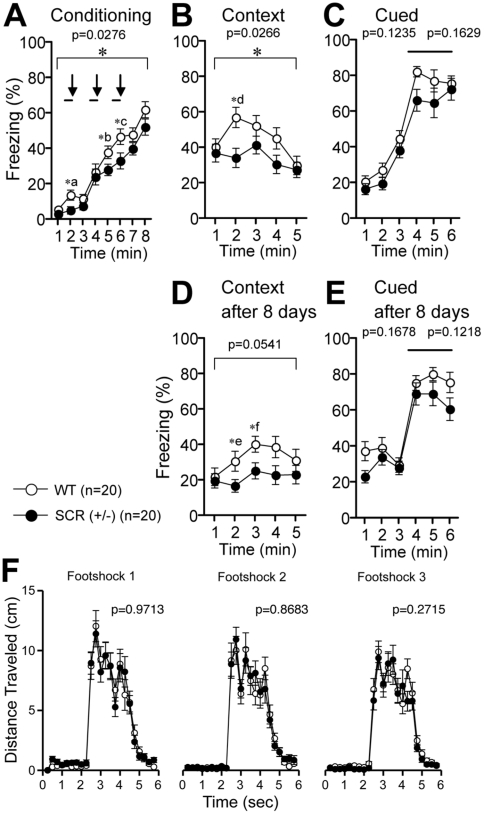
Contextual and cued fear conditioning in SCR (+/−) mice.(A) Percentage of time showing freezing during the training phase. A tone was presented for 30 s (bars) followed by a 2 s foot shock (arrows). (B) Reduced freezing was observed in the SCR (+/−) mice during the contextual test conducted at 24 h after conditioning. (C) Freezing during the tone-cued (bar) test with altered context in SCR (+/−) mice. (D, E) Retention of fear after 8 days. Percentage of time showing freezing during the contextual test in wild-type and SCR (+/−) mice (D) and freezing during the tone-cued (bar) test with altered context (E) at 8 days after conditioning. (F) Distance traveled soon after each foot shock at the training phase. (*) Significantly different in genotype effect, p<0.05. The p values indicate genotype effect in two-way repeated measures ANOVA (A–F). (*a–f) Post-hoc comparisons were performed using Fisher's PLSD multiple comparisons. (*a) p = 0.0187, (*b) p = 0.0454, (*c) p = 0.0367, (*d) p = 0.0064, (*e) p = 0.0440, (*f) p = 0.0244.